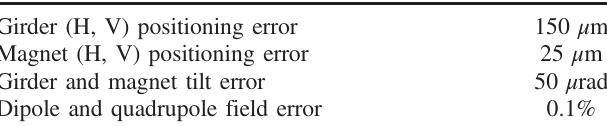
TABLE II. Standard deviation values for the Gaussian error distribution used to generate the 100 perturbed lattices.